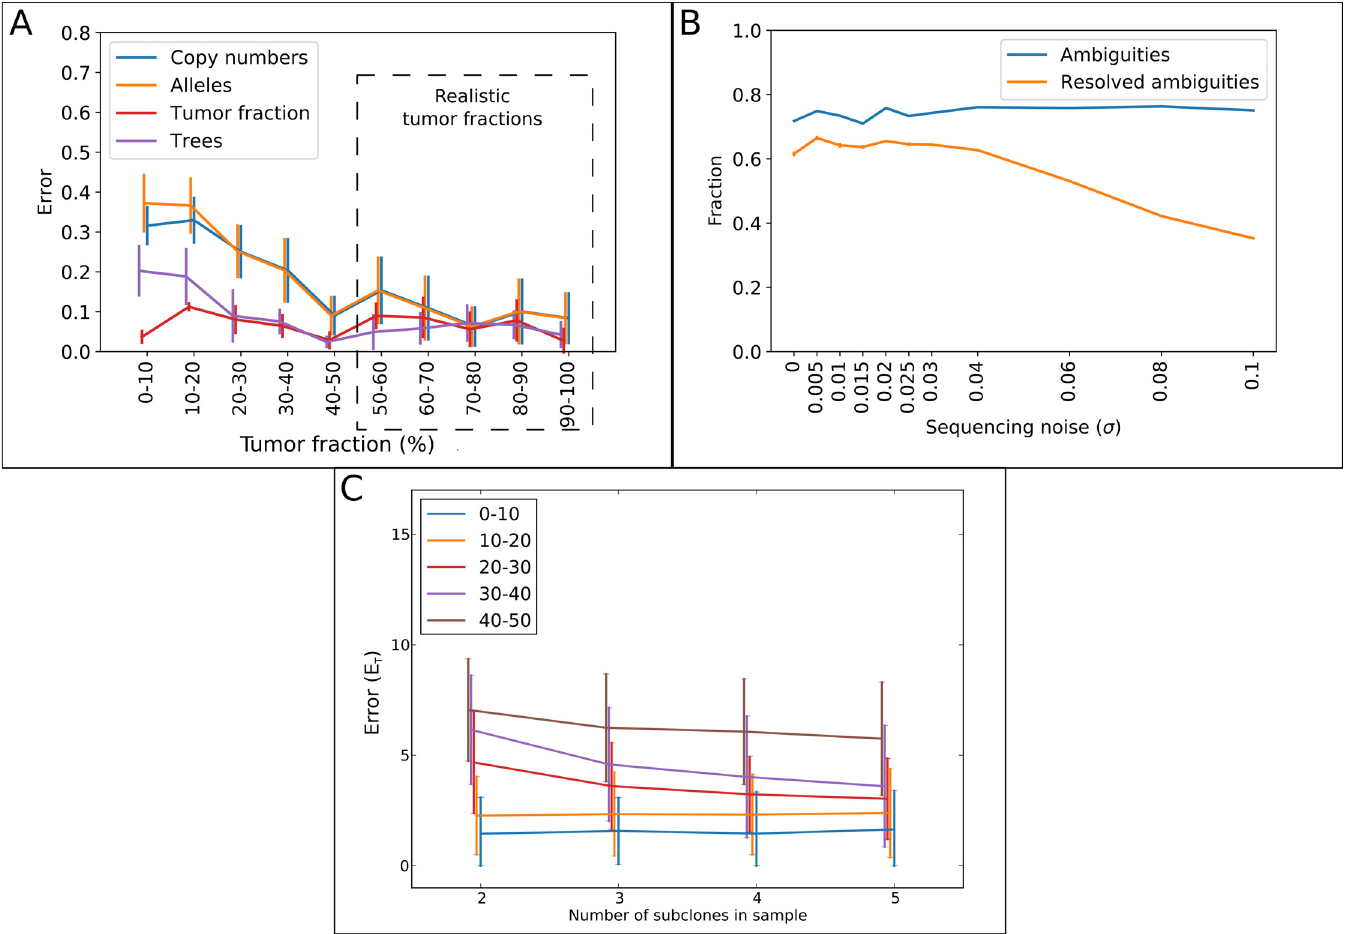
Fig 4. (A) Mean of the error rates and 95% confidence intervals as a function of different tumor fractions at a sequencing noise level of 0.02. Every μ was tested once. (B) The blue line shows the average fraction of ambiguous alleles that are present in 101 simulated datasets, each with a different tumor fraction between 0 and 1. The orange ^ ~ line indicates the mean and 95% confidence intervals of resolved ambiguities, normalized by the size of A . (C) Mean of the tree reconstruction error rates and 95% confidence intervals as a function of the number of subclones in the sample. A total of 100 simulations were performed for each number of subclones, for each of which a noise level of 0.02 and μ of 0.9 was selected. Each line shows the total percentage of the contaminating minor subclones in each sample. Every contamination percentage within the shown range was tested